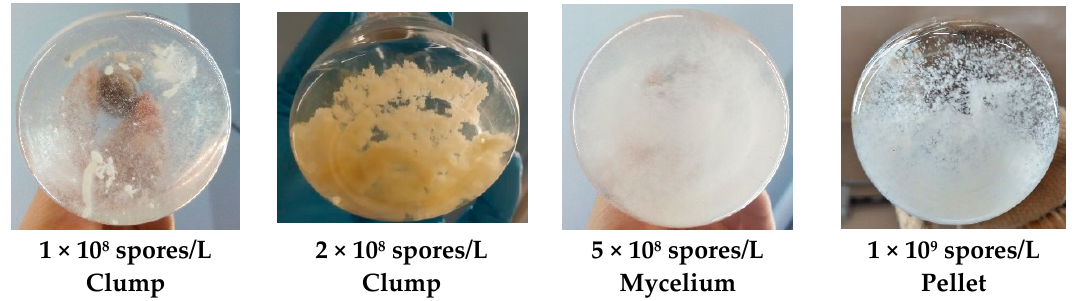
Figure 2. Different morphologies depending on initial spore concentration. Figure 2. Di ff erent morphologies depending on initial spore